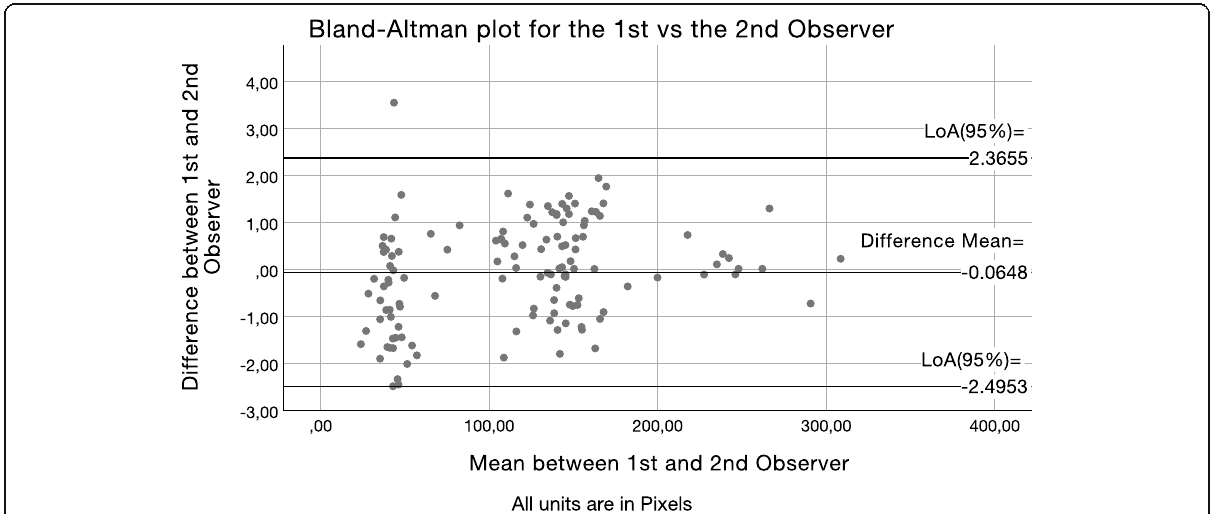
Fig. 4 Bland – Altman scatter plot of the difference between first observer ’ s average measurements versus the second observer ’ s (A). Y -axis: Difference between the first observer and the second observer (A). X -axis: Average of their measures. Difference mean: Estimated bias between the first observer and the second observer (A). LoA 95% limits of agreement at the 95% confidence